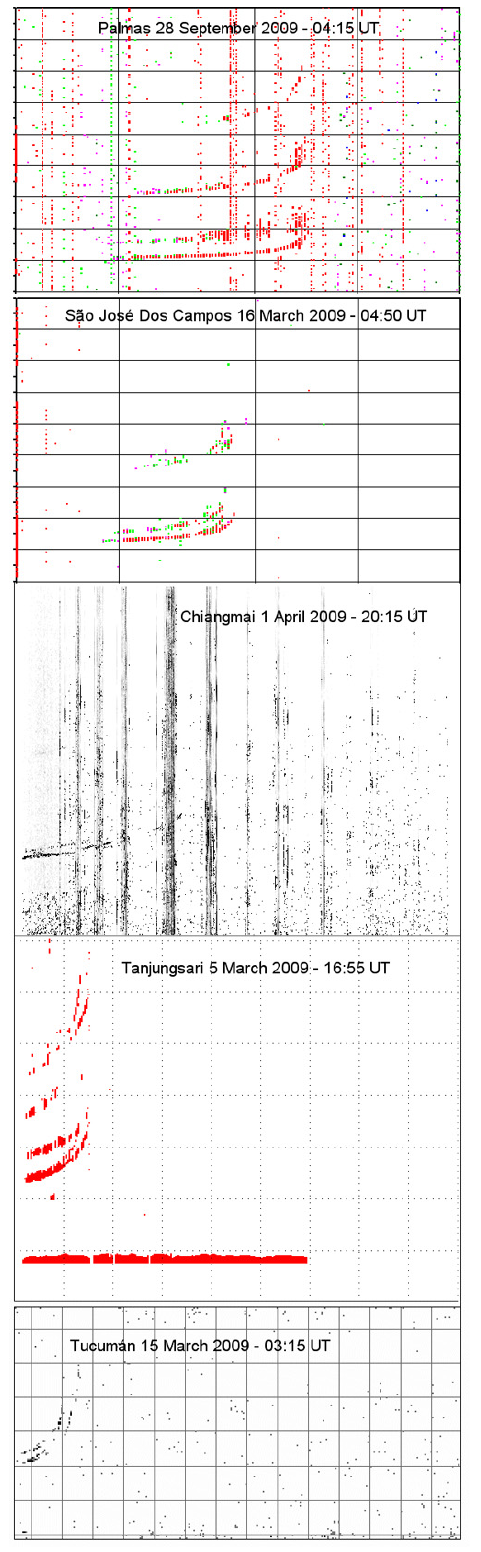
Fig. 4. Examples of satellite traces recorded at each of the iono- spheric stations considered in the